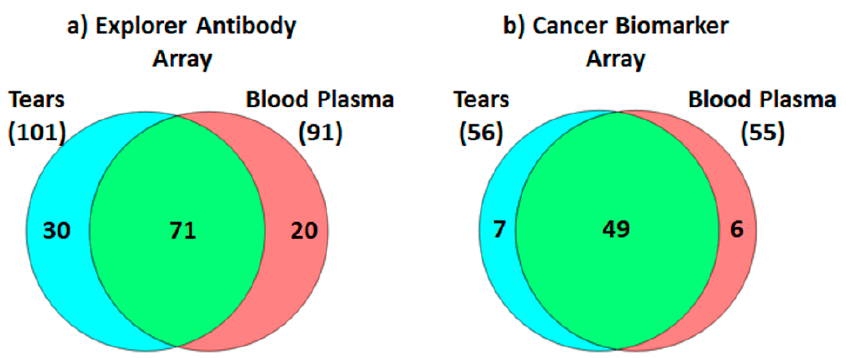
Figure 1. Microarray data analyzed for common protein expression in tears and plasma: ( a ) Explorer biomarker array, and ( b ) Cancer biomarker array.